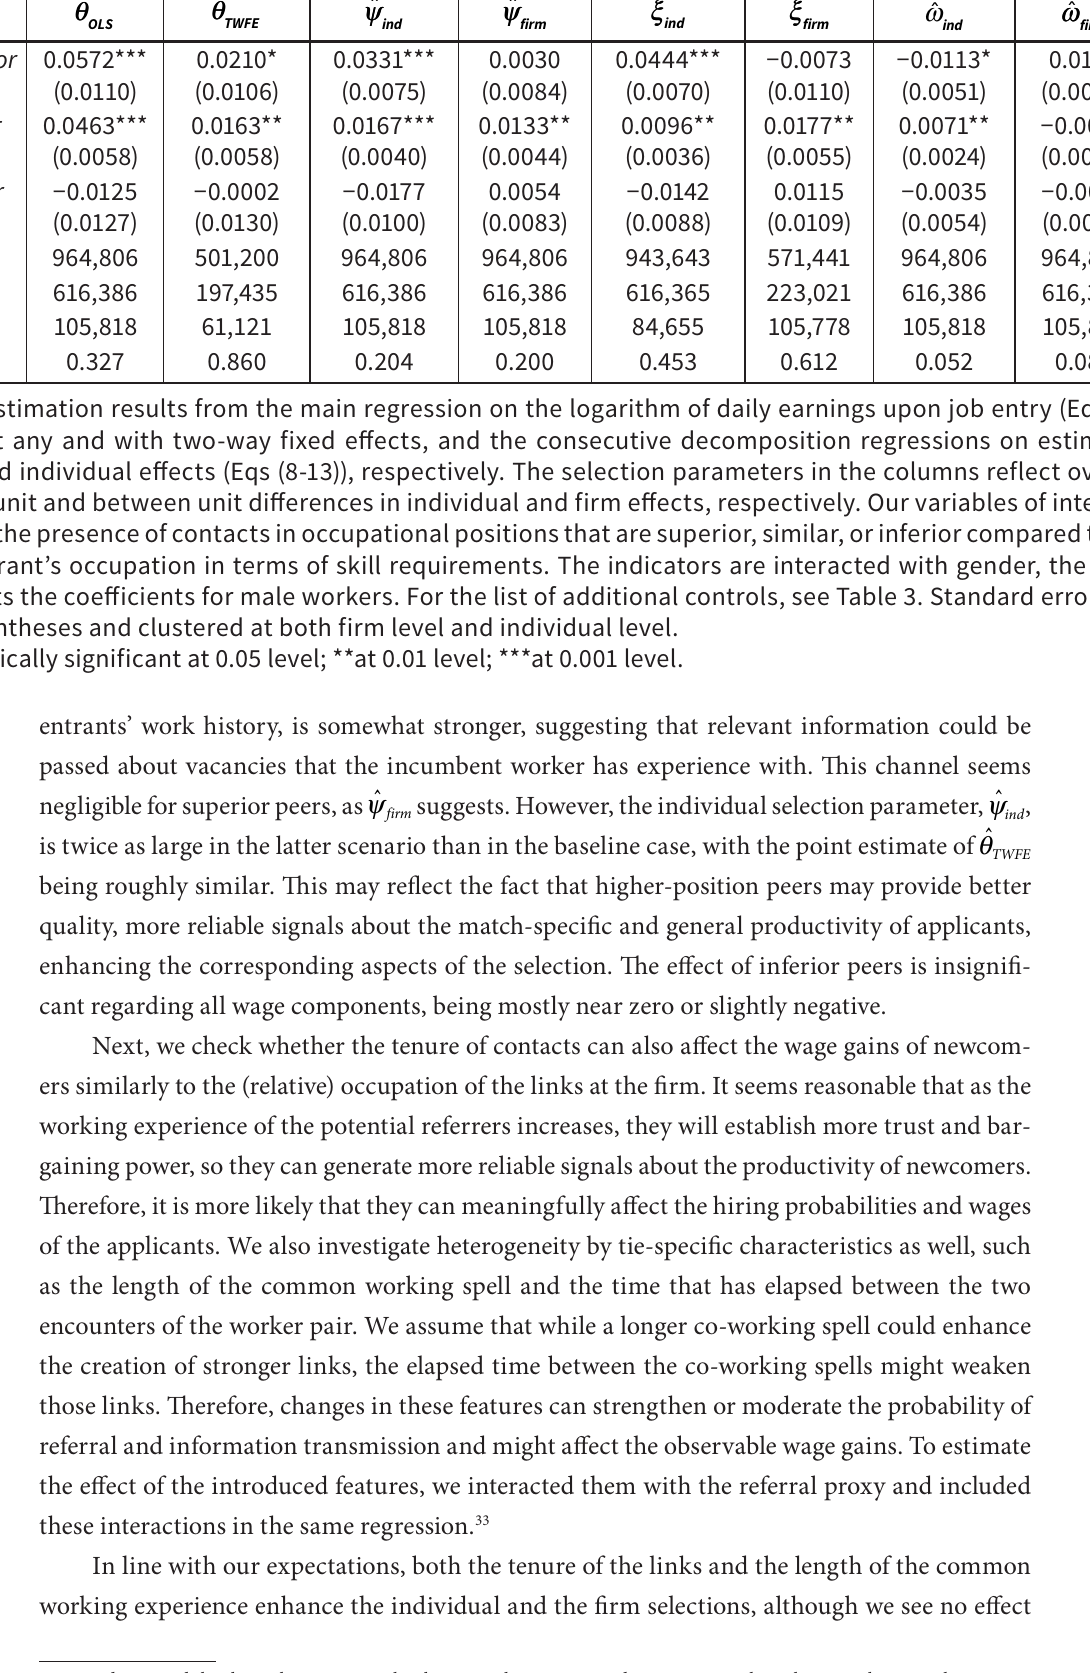
Heterogeneity of co-worker gains by relative position of contact θθ ˆ θθ ˆ OLS